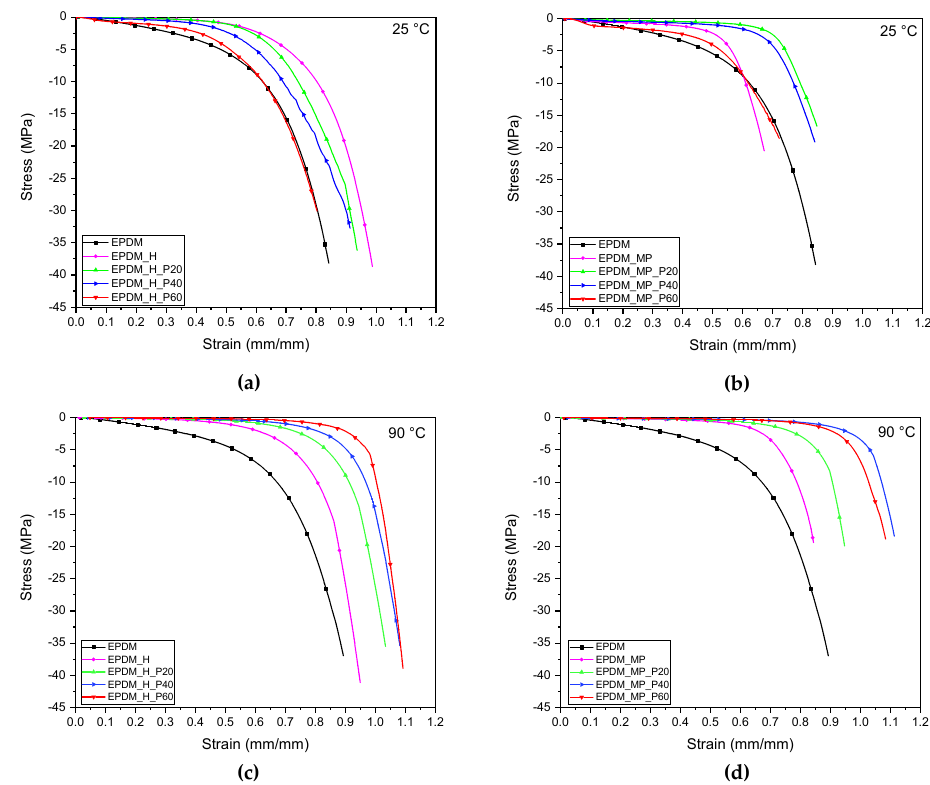
Figure 9. Representative compressive stress strain curves at 25 °C and 90 °C of bulk EPDM sample and foams produced with ( a , c ) H and ( b , d ) MP foaming agents.